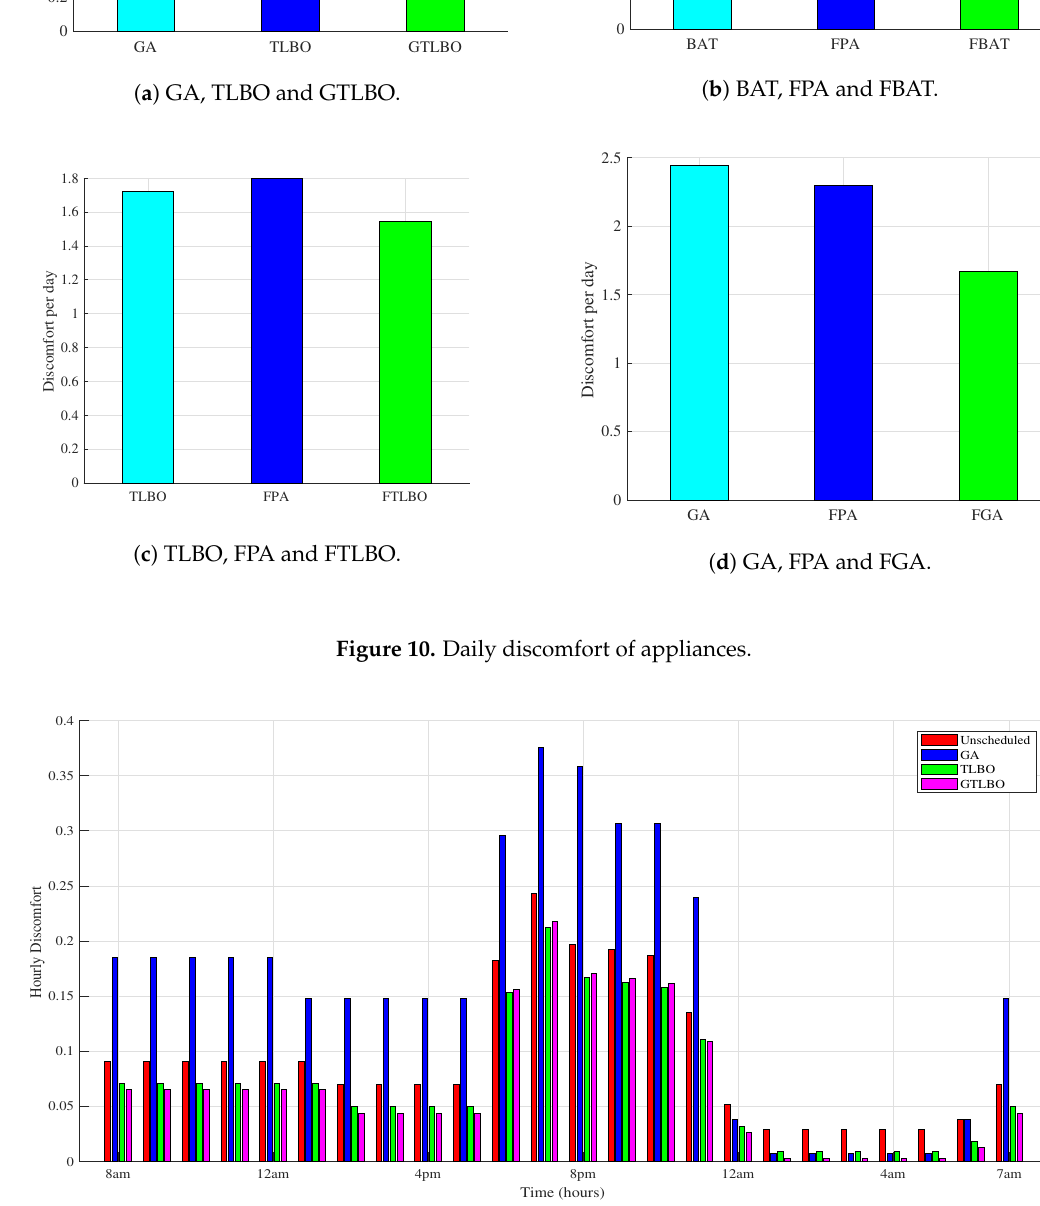
Figure 11. Hourly discomfort of